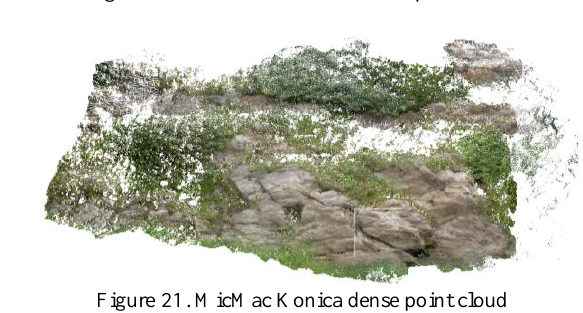
Figure 21. MicMac Konica dense point cloud